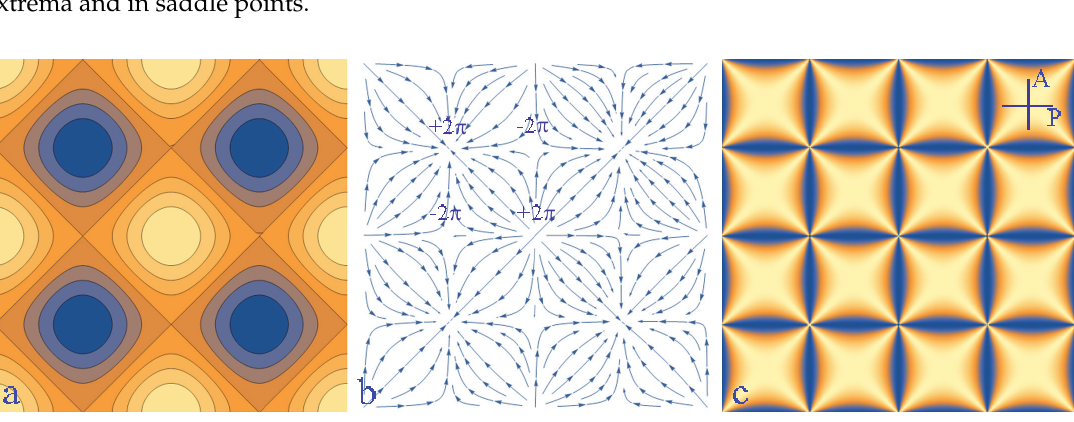
h or electric field ∇